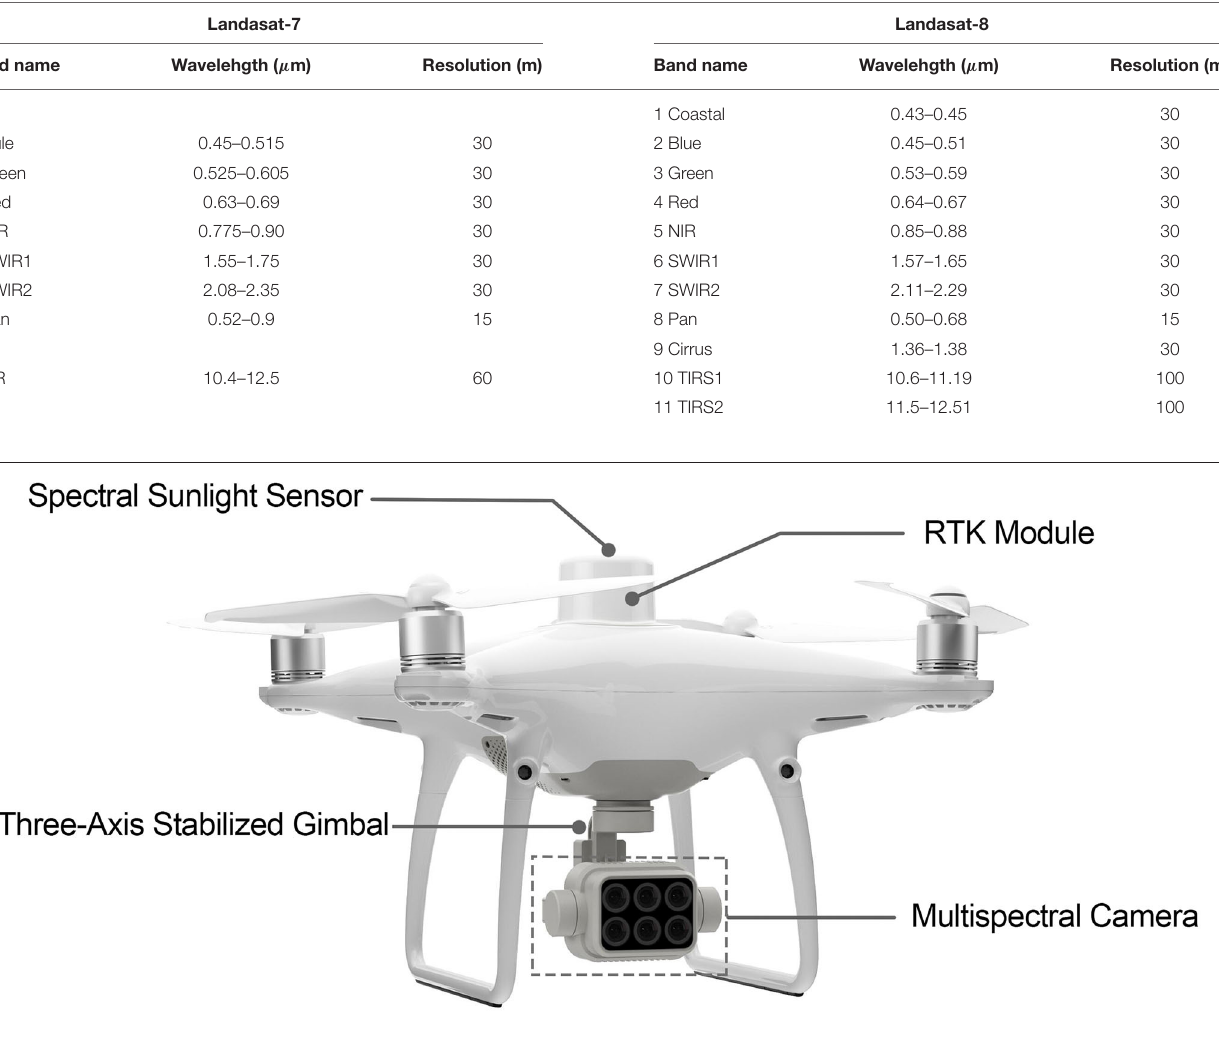
FIGURE 4 | Features of